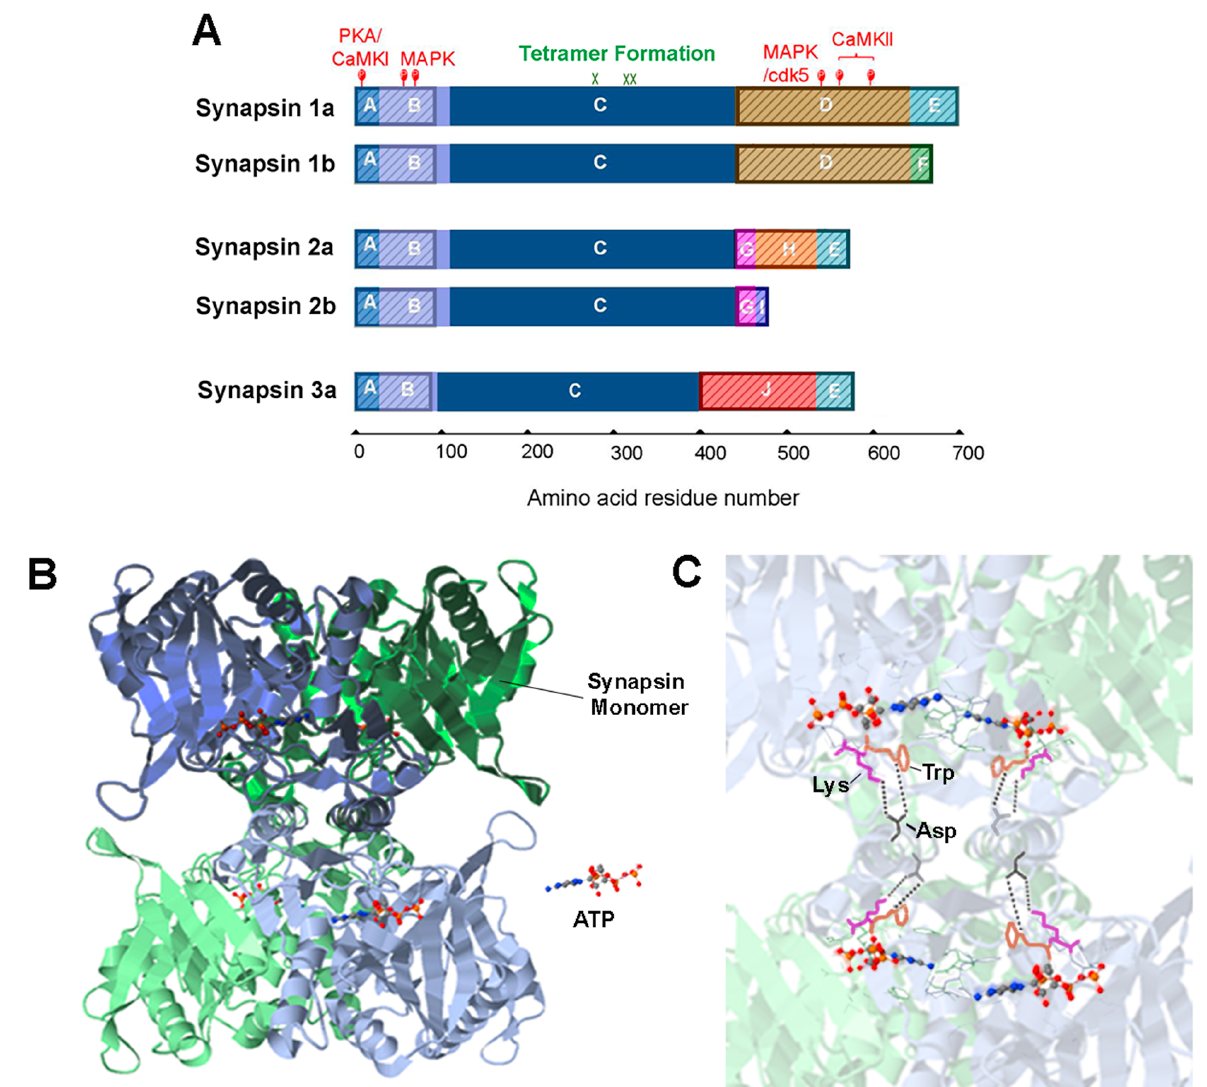
Figure 2. Synapsin domain structure and tetrameric structure of synapsins. ( A ). Synapsin isoforms consist of numerous domains, indicated by colors and letters. IDR regions are indicated by shading. Adapted from [41]. ( B ). Tetrameric structure formed by the C domain of synapsin 2 in the presence of ATP. Two synapsin monomers in a dimer—colored blue or green—are shaded with dark or light colors. A tetramer consists of two dimers. ( C ). The key residues mediating tetramer formation: aspartate (Asp, black), tryptophan (Trp, orange) and lysine (Lys, magenta); bonds between synapsin dimers are indicated by dashed lines. Structures in ( B , C ) adapted from data in [42], (accessible at PDB ID: 1i7l), visualized with the NGL viewer [43].